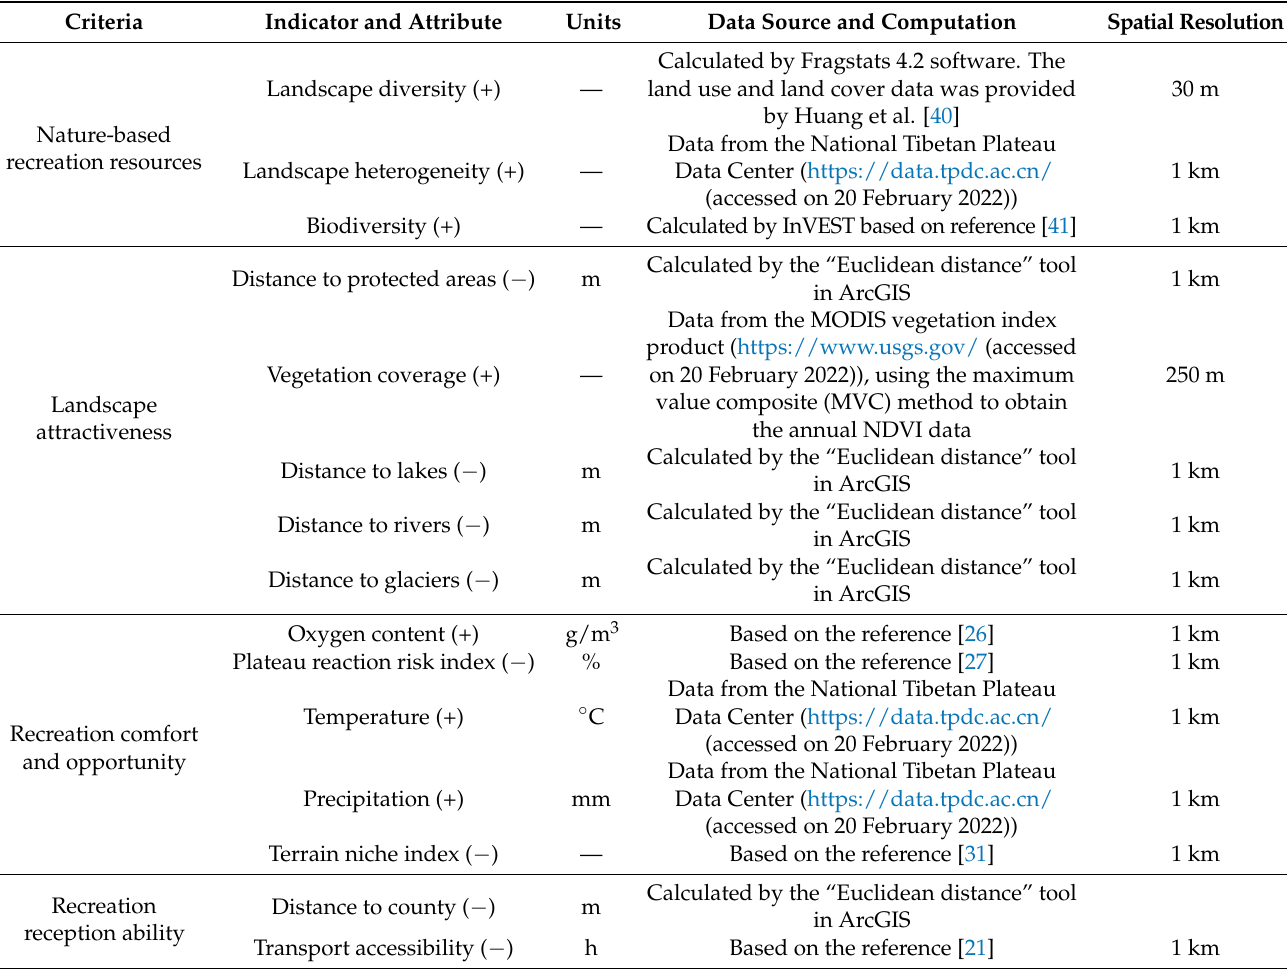
Table 1. Calculations of NBR potential index system in the